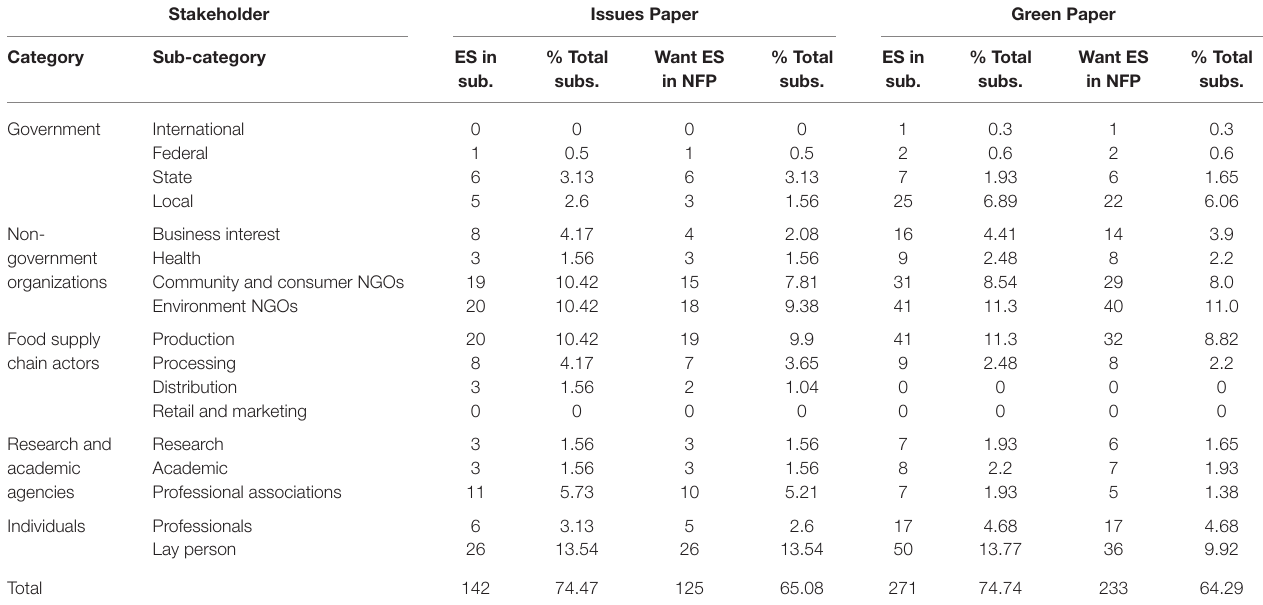
TaBle 2 | number and frequency of written submissions acknowledging environmental sustainability considerations and supporting inclusion in nFP per category and sub-category.